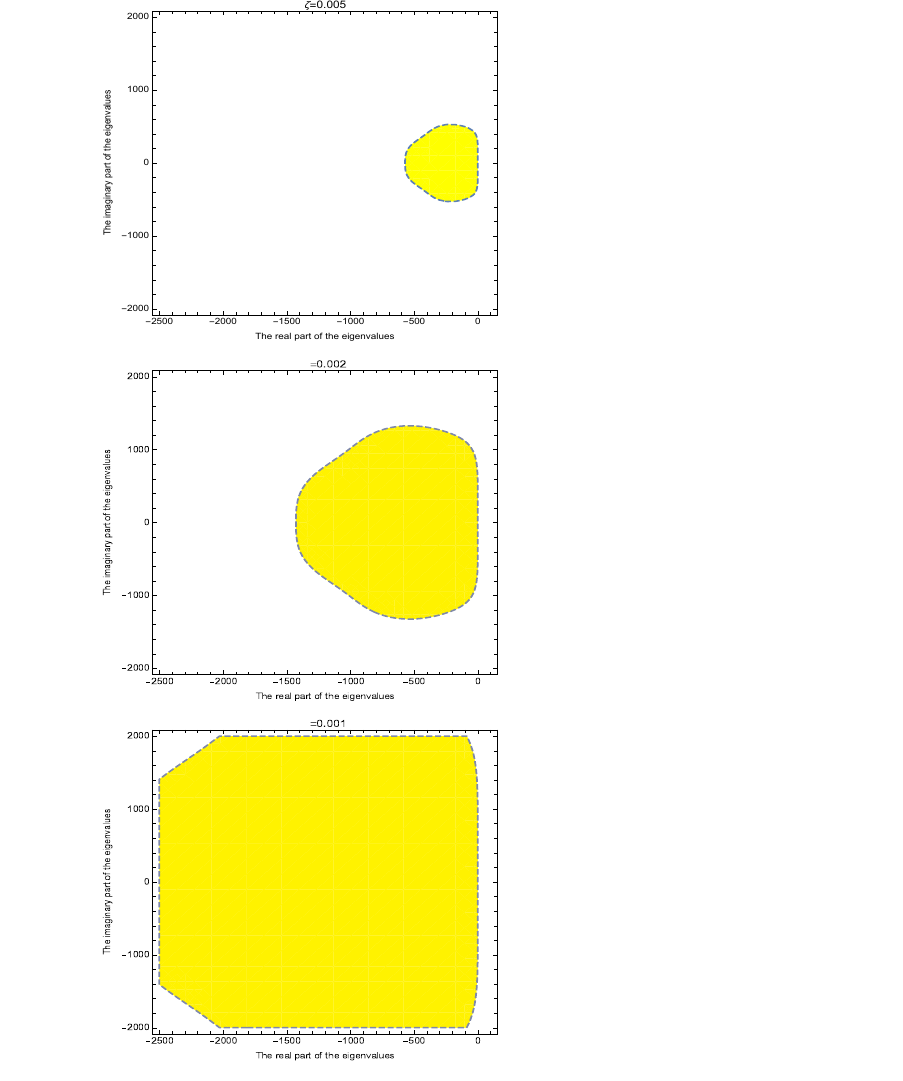
Figure 2. The numerical stability region of (44)–(46) for different values of ζ , i.e., ζ = 0.005, ζ = 0.002 and ζ =